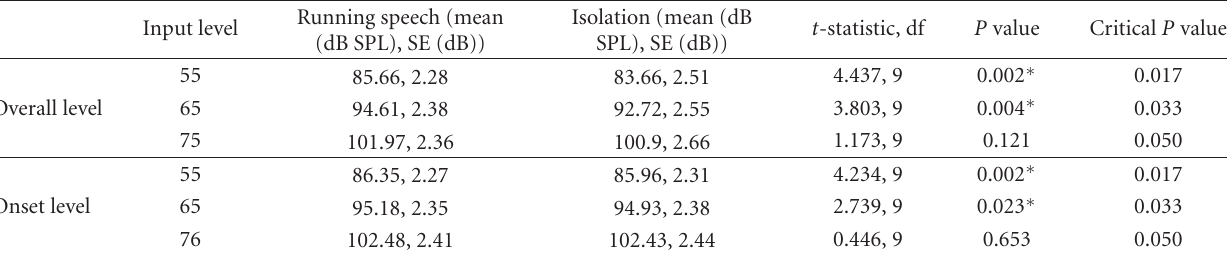
Figure 2: (a) presents variation of overall phoneme level in running speech and isolation context across input levels. (b) presents the same across phonemes. Error bars represent SE. ∗ indicates a statistically significant di ff erence in paired contrasts. The symbols have been o ff set slightly to improve clarity. Table 3: Results of post hoc tests for level context